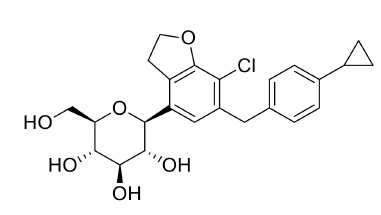
Figure 1. Chemical structure of